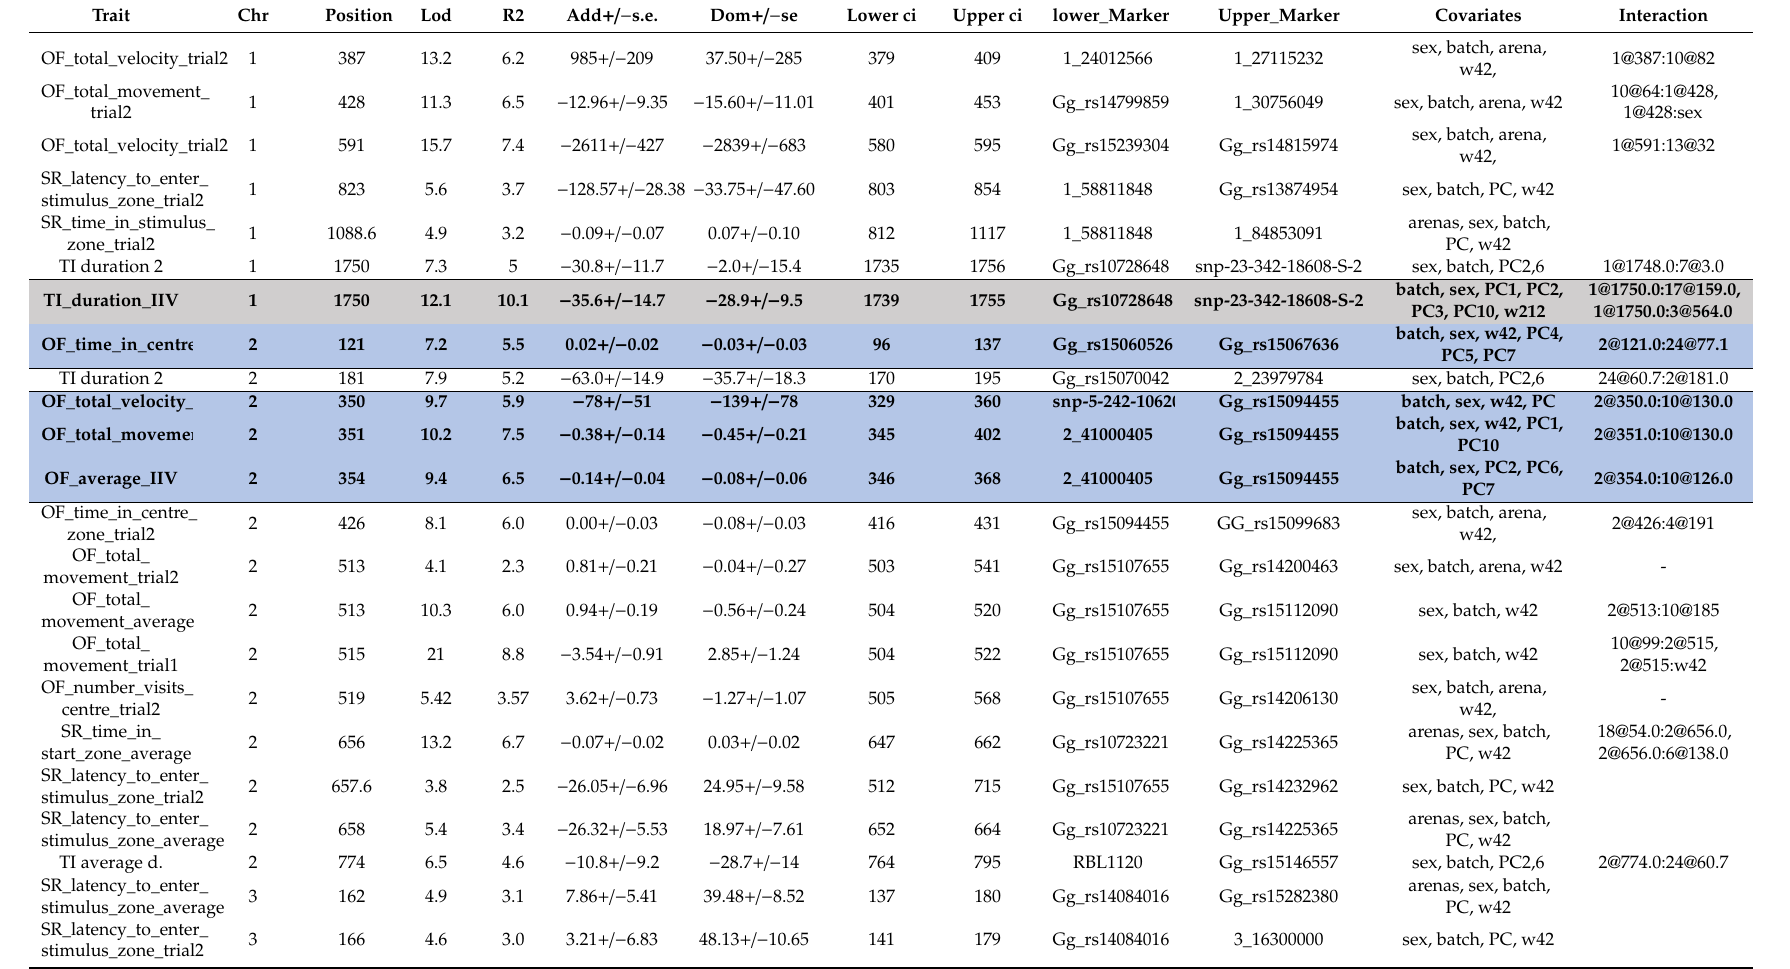
Table 2. QTL results of all IIV QTL as well as the standard trait QTL (based on individual trials and mean traits) from the same